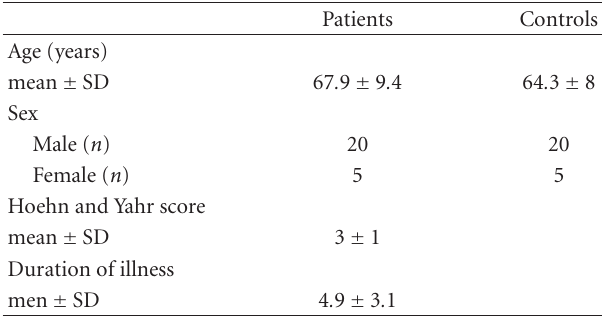
Table 1: Age, sex, and clinic features of the patients with PD and healthy controls.